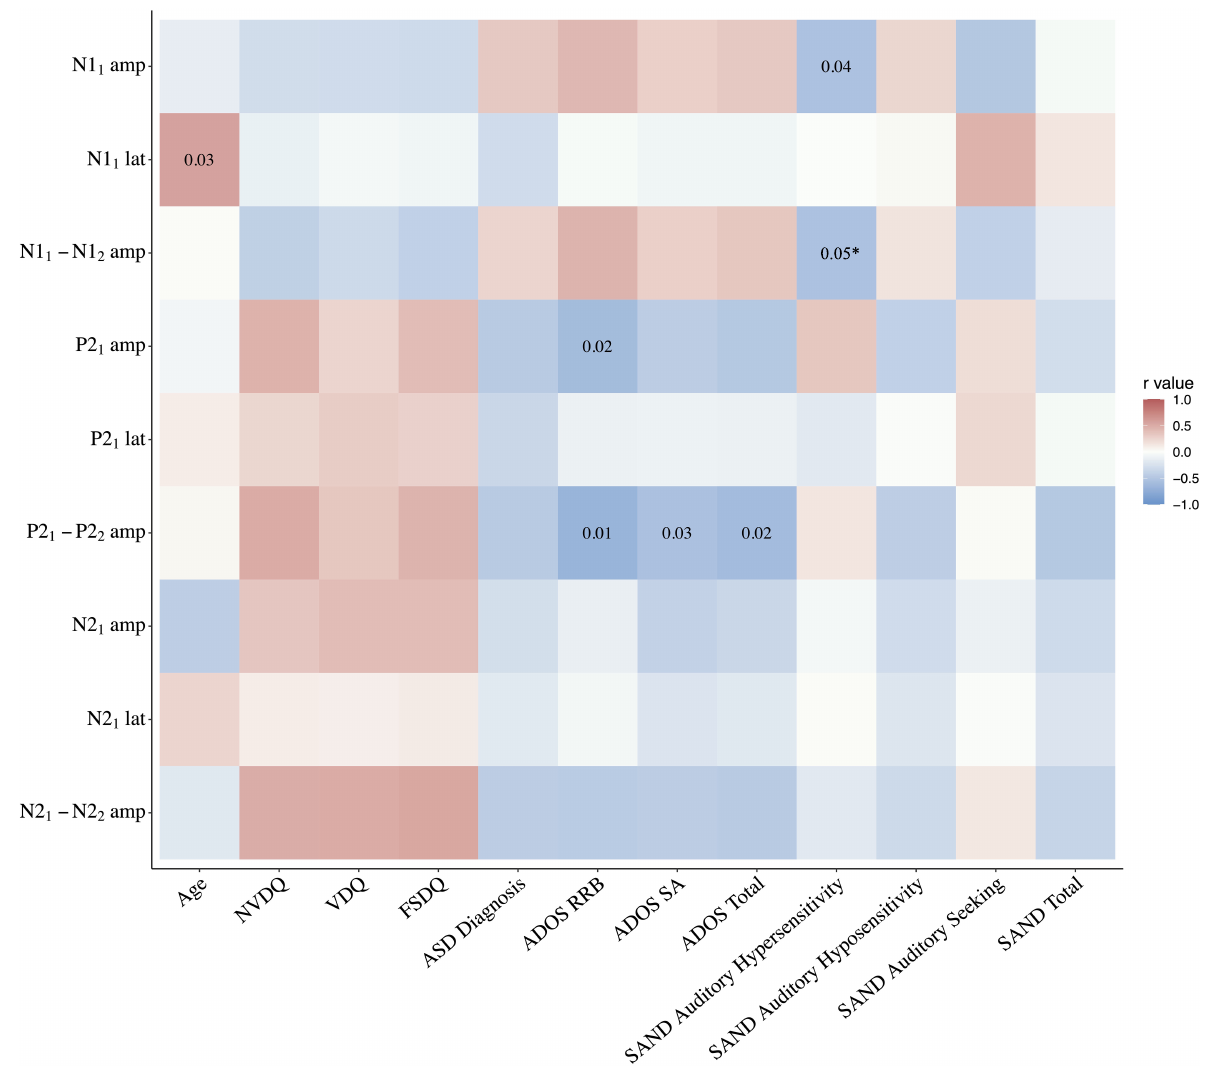
FIGURE 3 | Correlation heatmap of electrophysiologic findings and clinical indices in the PMS group. *Correlation between SAND auditory hypersensitivity and N1 1 − 2 habituation p = 0.048. amp, amplitude; lat, latency; NVDQ, Non-verbal Developmental Quotient; VDQ, Verbal Developmental Quotient; FSDQ, Full Scale Developmental Quotient; ADOS, Autism Diagnostic Observation Scale; RRB, Restricted and Repetitive Behaviors; SA, social affect; SAND, Sensory Assessment for Neurodevelopmental